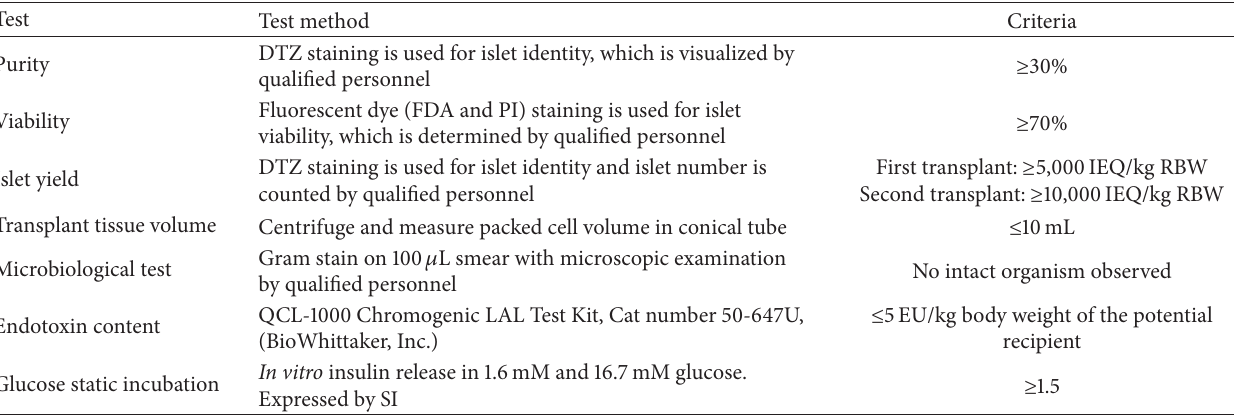
Table 2: Product-Release Test for islets before